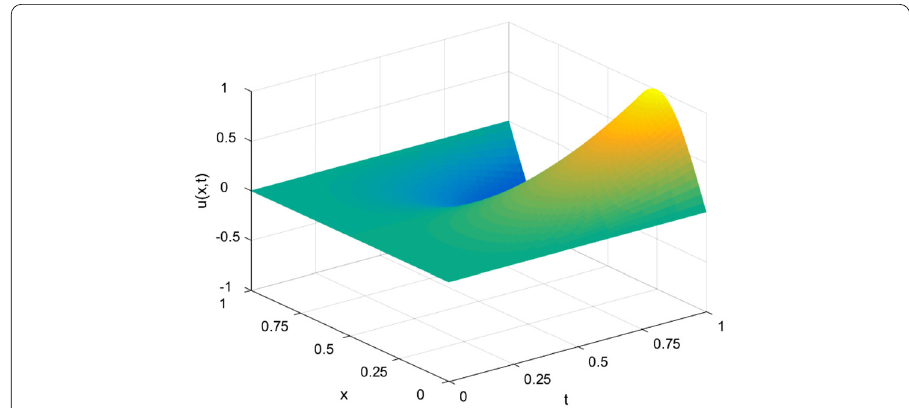
Figure 4 Surface of the C–N scheme solution ( α = 0.7)